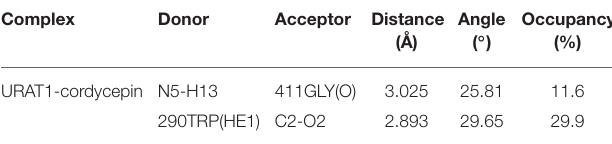
TABLE 3 | Hydrogen bond analysis of MD trajectory. Complex